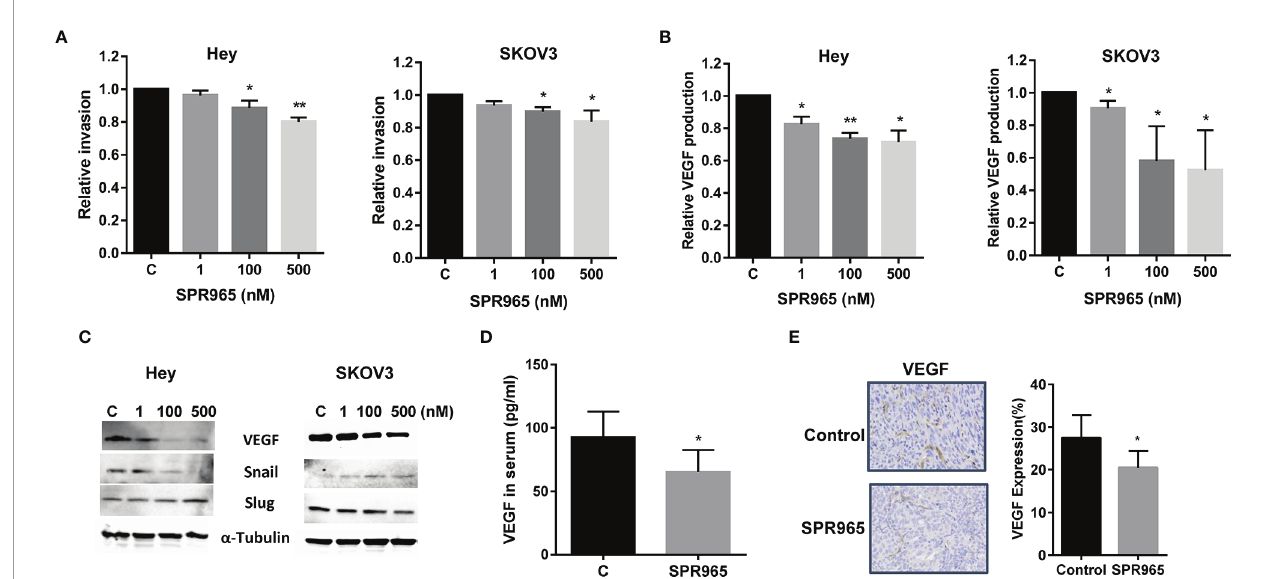
FIGURE 5 | SPR965 inhibited invasion in ovarian cancer cells. SPR965 inhibited cell invasion in the Hey and SKOV3 cells, assessed by transwell assays (A) . The Hey and SKOV3 cells were treated with SPR965 for 24 h. VEGF products in the media were assessed by VEGF ELISA assay (B) . Western blotting results indicated that SPR965 affected the expression of epithelial-mesenchymal transition (EMT) markers including an increase in Slug in Hey cells and a decrease in Snail in both cell lines (C) . SPR965 reduced serum VEGF levels in SPR965-treated KpB mice at the end of treatment (D) . Immunohistochemistry results con fi rmed that SPR965 signi fi cantly reduced the expression of VEGF in ovarian tumors of KpB mice (E) . *P < 0.05,